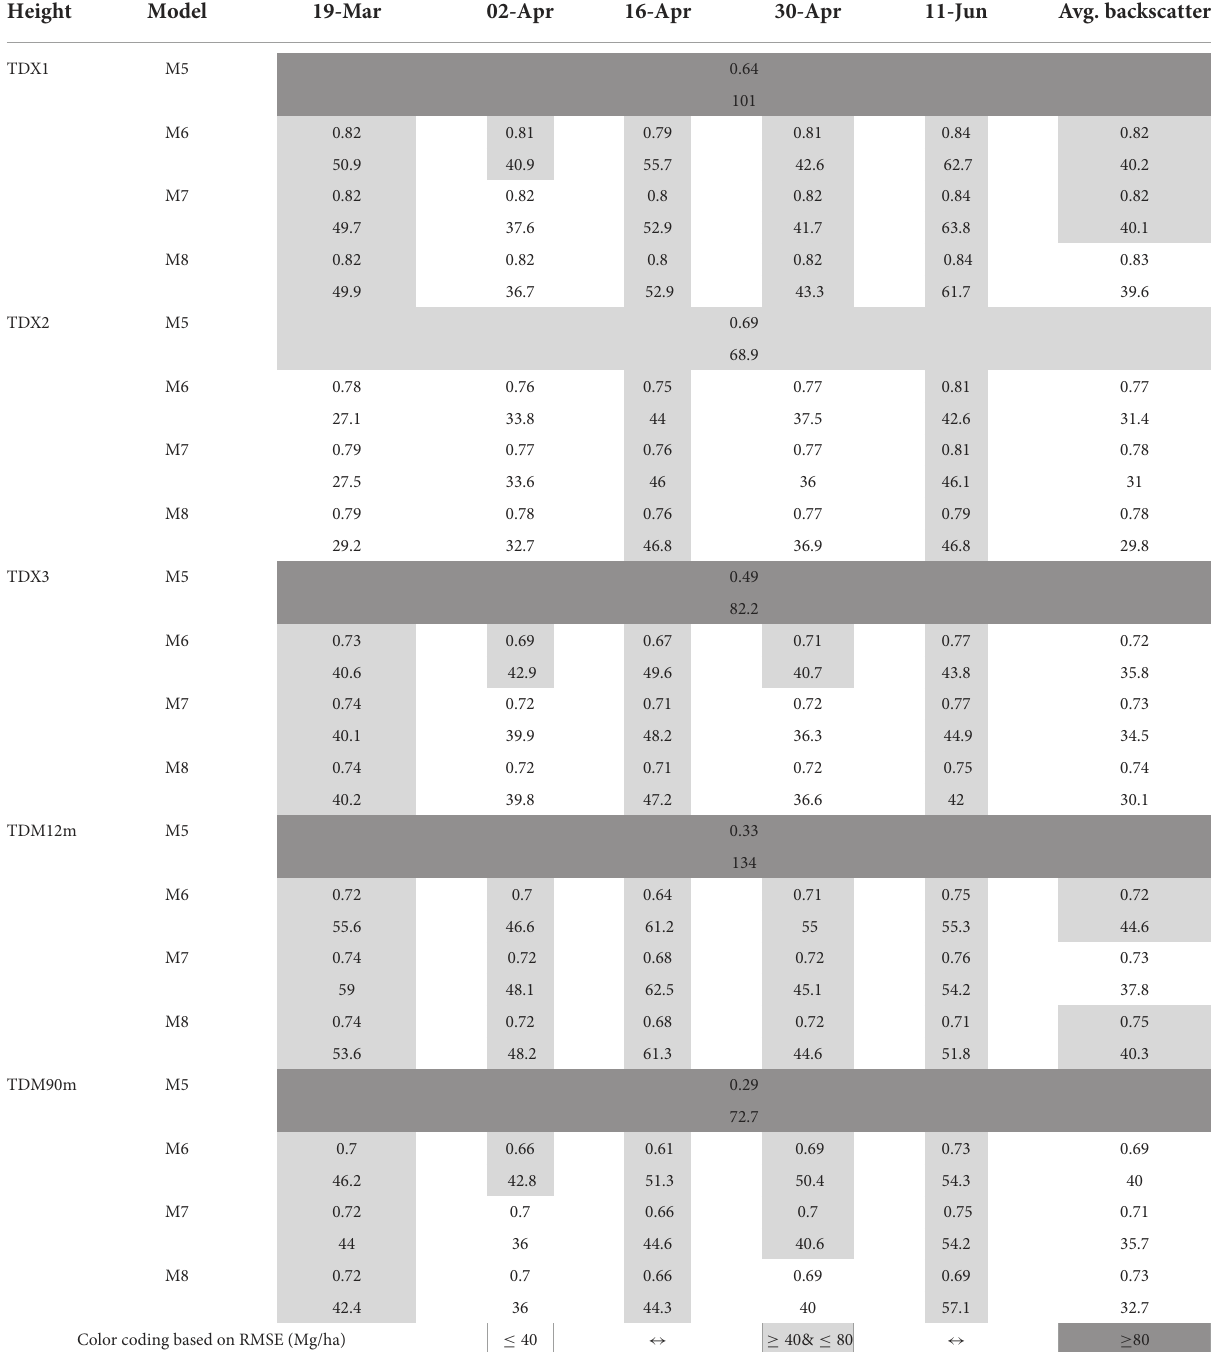
TABLE 4 Validation of combined models for all five heights and five L-band acquisitions.